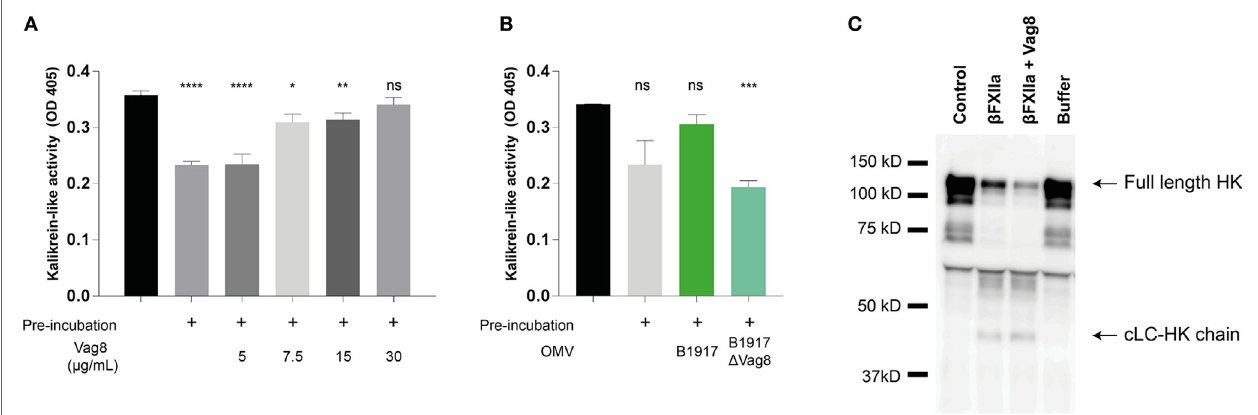
FigUre 3 | Virulence associated gene 8 (Vag8) induces enhanced activation of the contact system in plasma. (a) 60% plasma was incubated with Vag8 (5, 7.5, 15, and 30 µg/mL) following 10 min pre-incubation with 0.5 µg/mL β FXIIa. Vag8 dose-dependently enhances the induced kallikrein-like activity reaching similar levels upon using 7.5 µg/mL of Vag8 as the maximum kallikrein-like activity observed by β FXIIa alone without pre-incubation. (B) Moreover, the kallikrein-like activity in 60% plasma was also enhanced in the presence of endogenous Vag8 on outer membrane vesicles (OMVs) (60 µg/mL) derived from the wild type Bordetella pertussis strain B1917 but not when using OMVs of the knockout strain B1917 Δ Vag8. (c) Enhanced contact system activation was also shown by immunoblot. 90% plasma was incubated with 0.5 µg/mL β FXIIa either in the presence of 60 µg/mL Vag8 or buffer for 10 min and analyzed using anti-high-molecular-weight-kininogen (HK). The presence of Vag8 results in increased cleavage of the ~120 kDa full length HK compared to β FXIIa alone and the detection of the ~46 kDa cLC-HK chain (note the second and third lane). Plasma alone at t = 0 (control) and without β FXIIa at t = 10 (buffer) showed no cleavage of HK. Data shown in panel (a) represent the mean ± SEM of three separate experiments, while panels B and c are representative of three separate experiments. * p ≤ 0.05, ** p ≤ 0.01, *** p ≤ 0.001, **** p ≤ 0.0001, ns, non-significant compared to the black